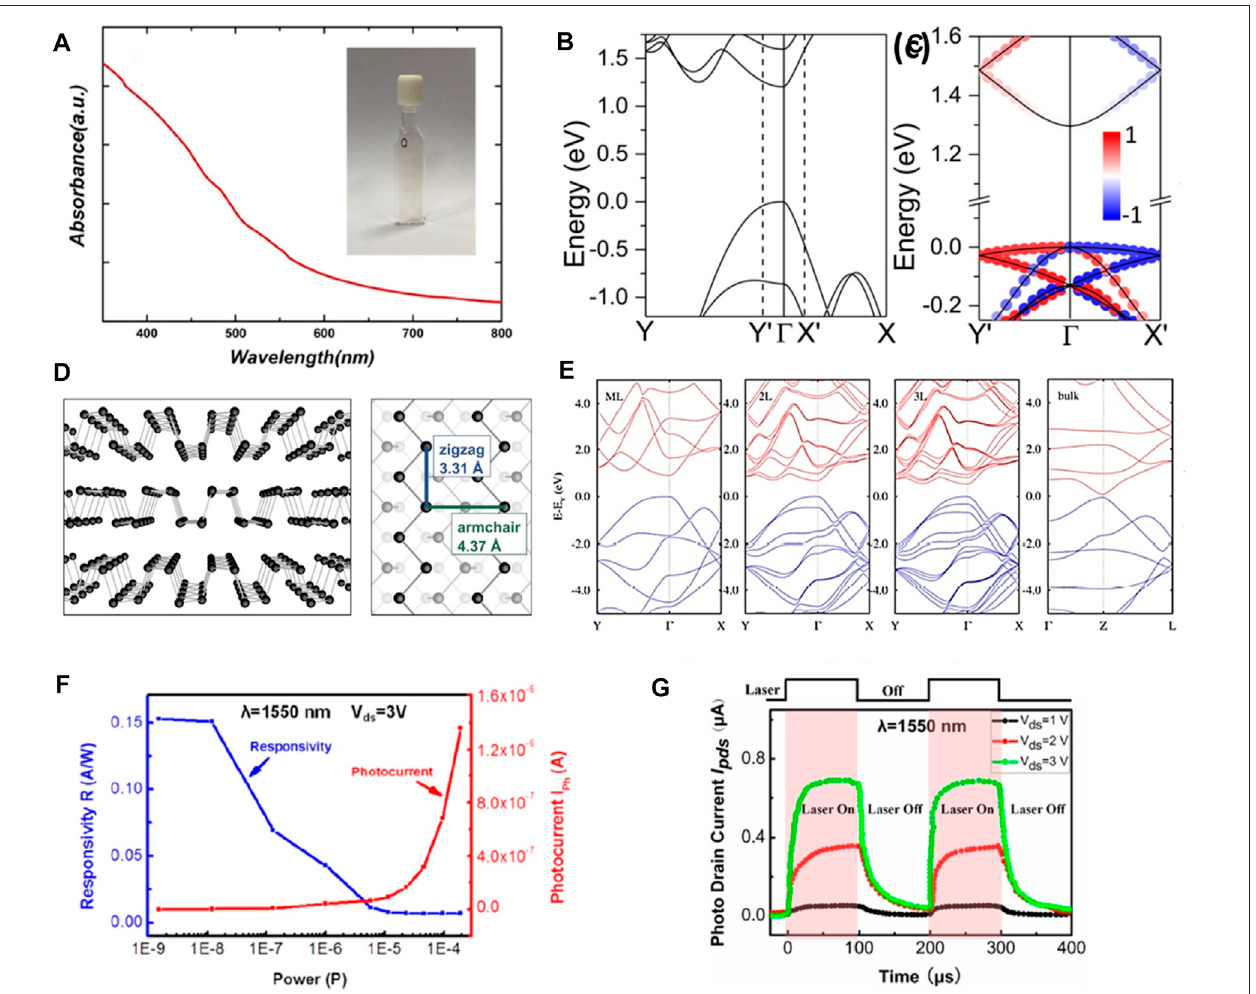
FIGURE 5 | (A) UV-Vis absorption spectrum of the BP. Inset shows the digital photograph of the BP dispersion [adapted and modi fi ed from (Huang et al., 2017)]. (B) GWquasiparticlebandstructureofnaturallystackedbilayerBPand (C) 90 ° twisted bilayerBP[adapted andmodi fi edfrom(Caoetal.,2016)]. (D) Crystalstructureof BP [adapted and modi fi ed from Zahn et al., 2020)]. (E) Calculated electronic band structures of BP with different thicknesses [adapted and modi fi ed from (Lu et al., 2016)]. (F)